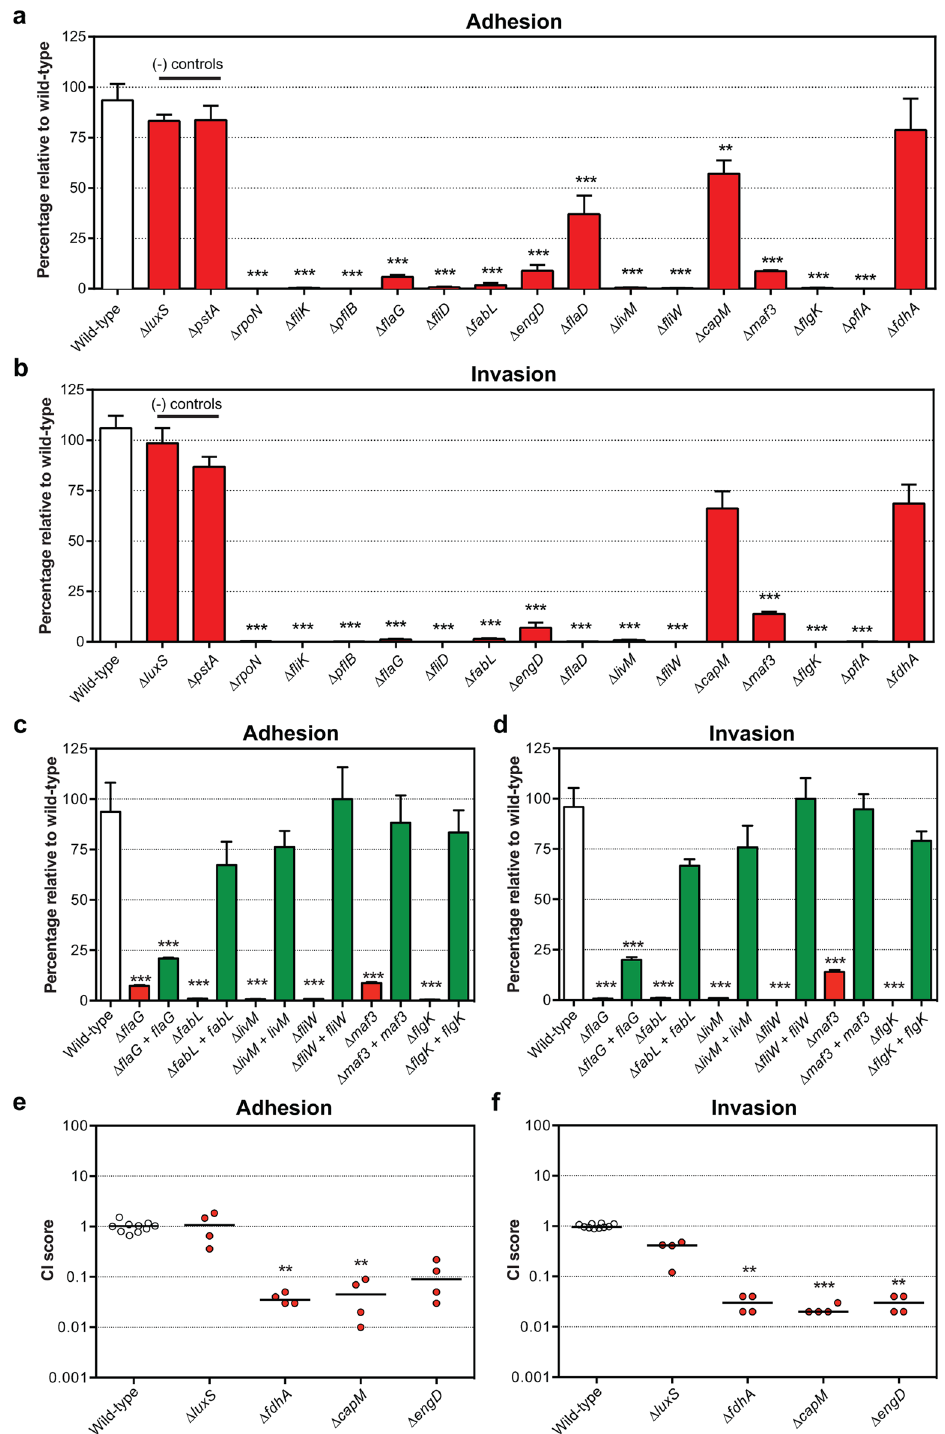
Figure 7. Validation of Tn mutant library screen during adhesion and invasion of human gut epithelial tissue culture cells. Adhesion to ( a ), and invasion ( b ) of, Caco-2 cells by C . jejuni M1cam defined gene deletion mutants. Mutants in luxS and pstA , which were not identified in our Tn-seq screen with Caco-2 cells, were included as negative controls and rpoN , which was previously shown to be required for adhesion and invasion 81, 82 , served as a positive control. Caco-2 adhesion ( c ), and invasion ( d ), of gene deletion and genetically complemented mutants. Data is represented as percentage of wild-type ( n ≥ 3) and plotted as means and SEM. The competitive index (CI) was calculated by dividing the ratio of mutant to wild-type bacteria recovered upon ( e ) adhesion to, and ( f ) invasion of, Caco-2 cells by the ratio of mutant to wild-type bacteria that were used in the inoculum. Statistical significance was calculated using a Mann-Whitney test where * P < 0.05, ** P < 0.01 and *** P <